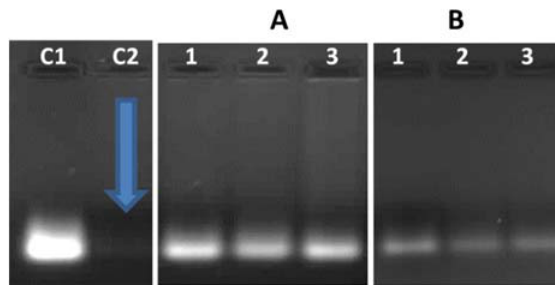
Figure 5. Nuclease digestion studies of NP ‐ siRNA nanocomplexes. C1: siRNA only (0.5 μ g/mL); C2: siRNA treated with RNase A; gel ( A ) lanes 1–3: siRNA ‐ SeCh at w/w ratios (1:5, 1:6, and 1:7) and gel